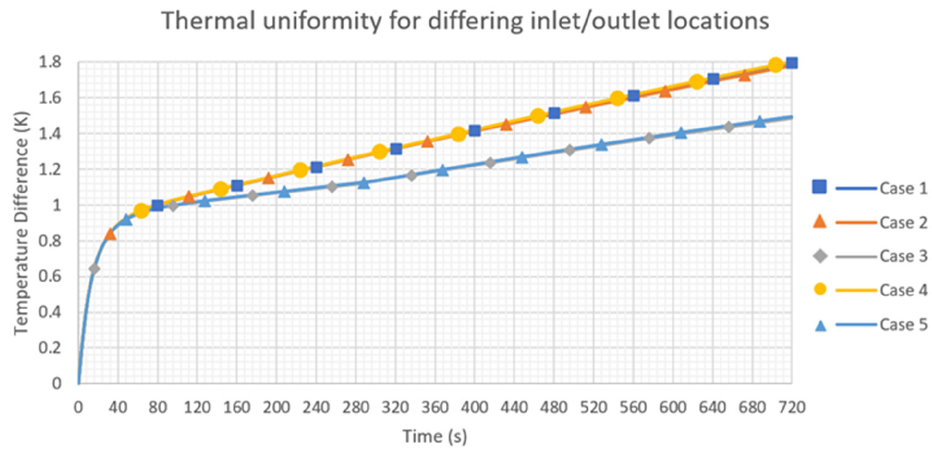
Figure 10. Cell temperature difference over discharge cycle for differing inlet/outlet locations–LCD.